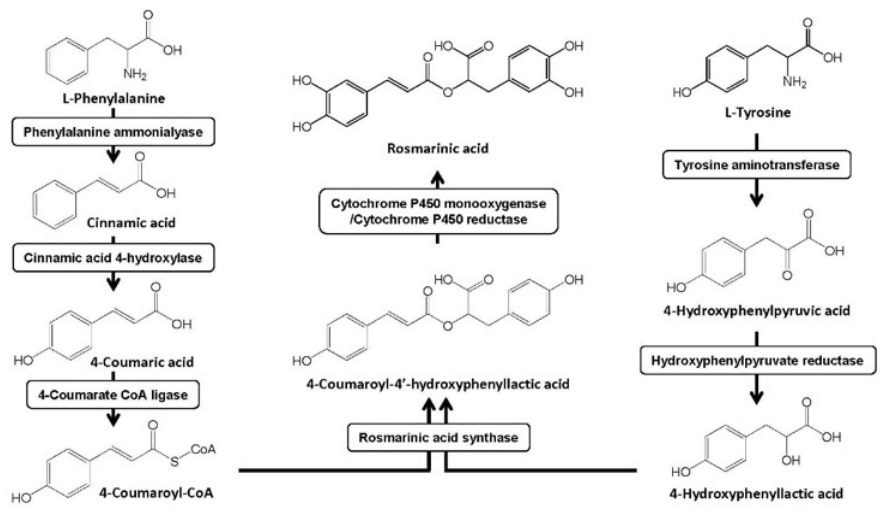
Figure 2. Biosynthesis pathway of RA in the plants.